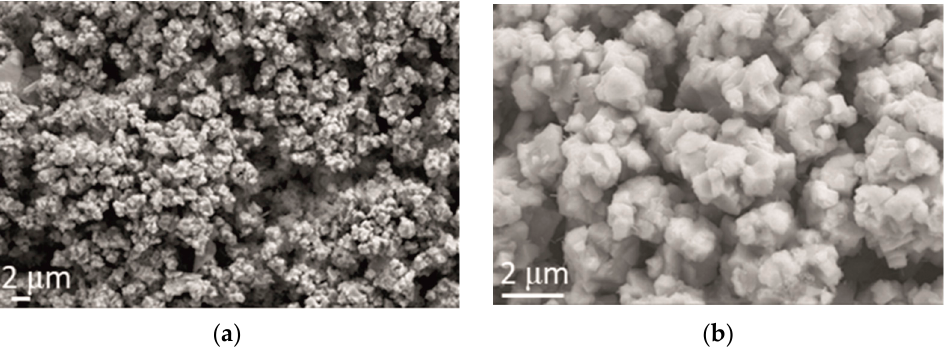
Figure 6. Morphology of Zn-Co-CeO 2 coating obtained by electrodeposition at a current density of 2 A dm − 2 from the electrolyte with an addition of CeO 2 in the form of powder. Magnification: ( a ) ×5000 and ( b ) ×20,000.